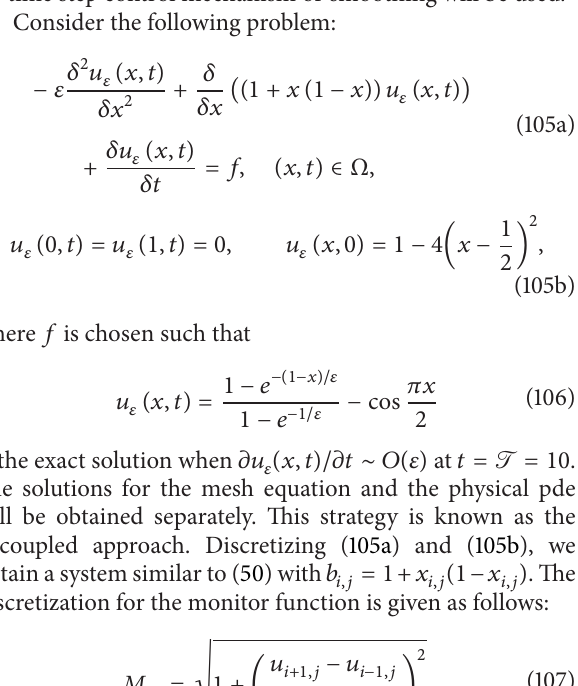
Figure 2: Numerical solutions for 𝜀 = 2 −14 and 𝑁 = 64